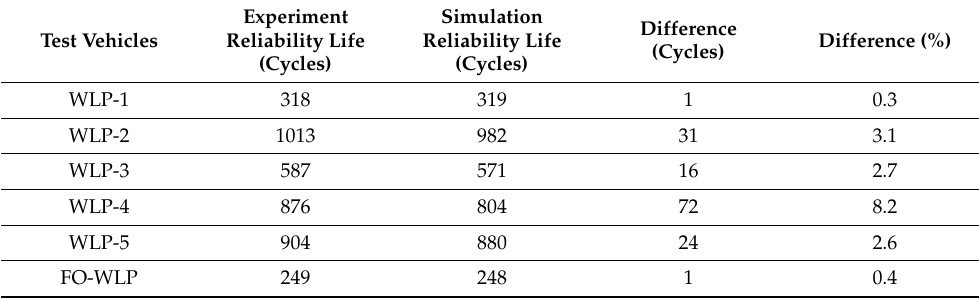
Table 5. Reliability comparison for six test vehicles.